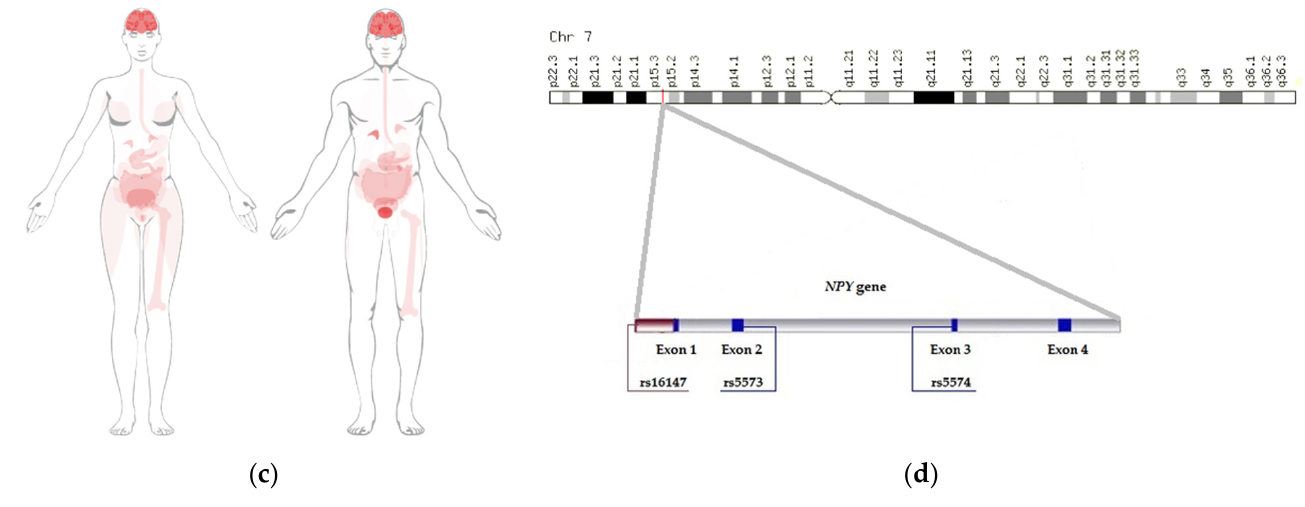
Figure 1. Structure ( a ) and tissue expression ( b , c ) of a neuropeptide Y [6]; chromosome location of the NPY gene ( d ) [9].